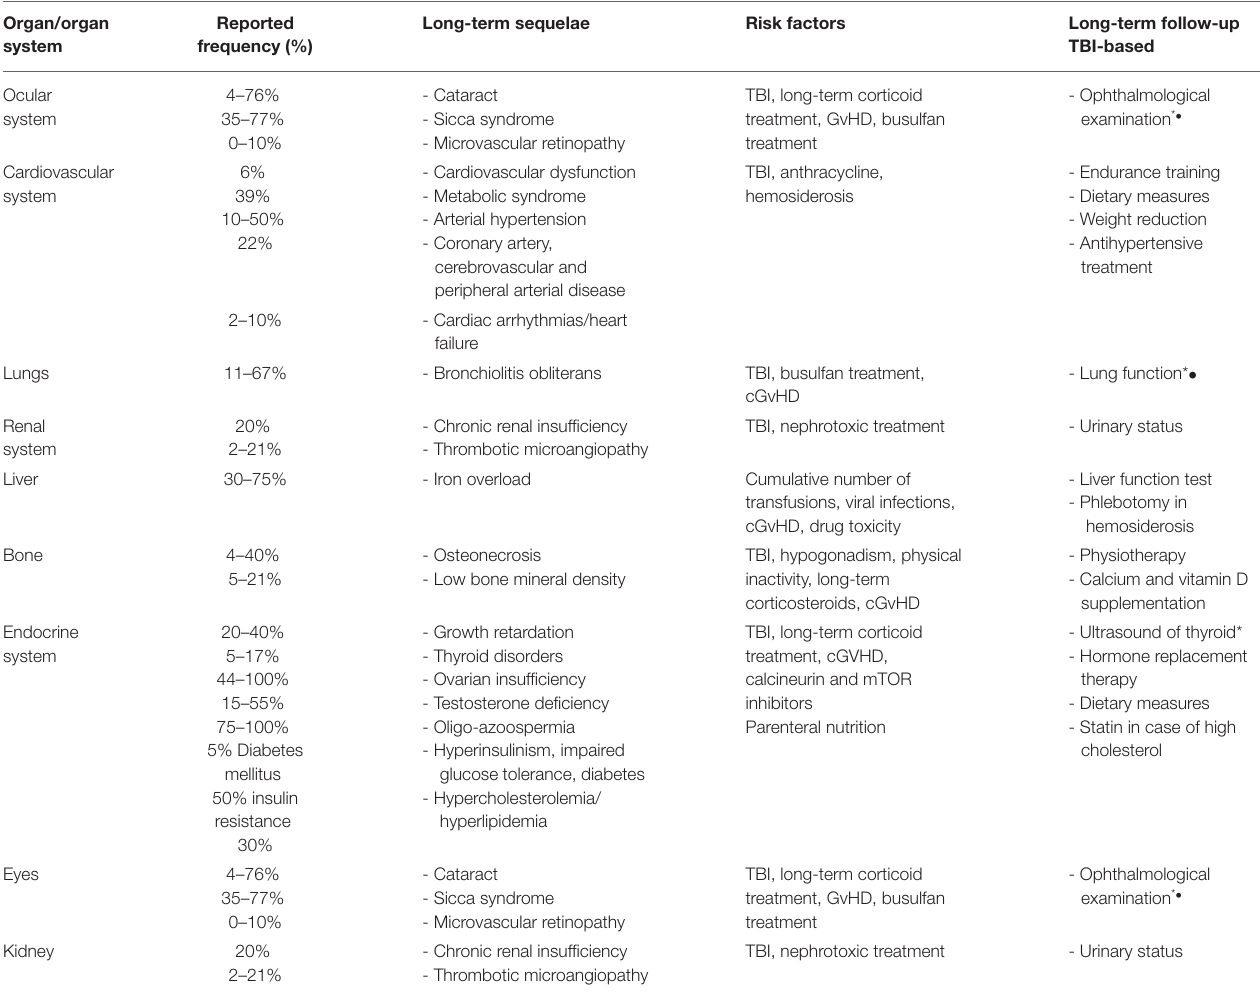
TABLE 1 | Reported frequency of long-term sequalae in ALL survivors treated with HSCT during childhood. Organ/organ